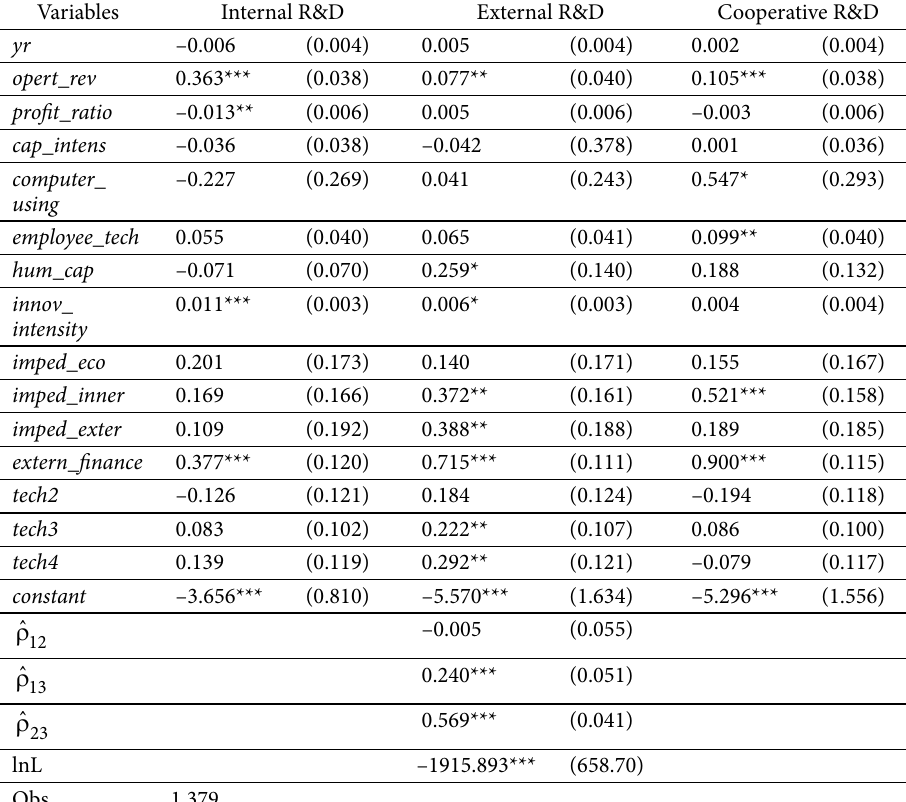
Table A-2. Multivariate probit results of choosing R&D strategies